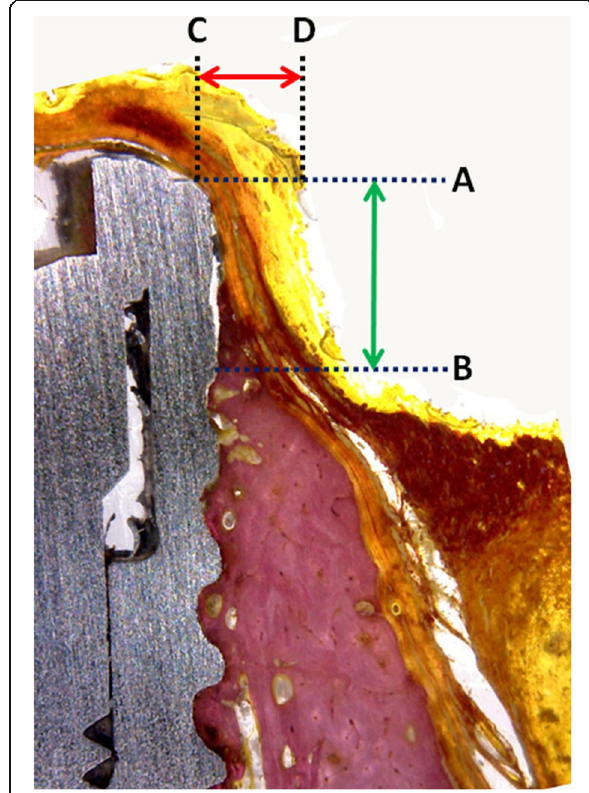
Fig. 2 Parameters measured in each group. Crestal bone loss is the distance between the implant collar (A) and the first bone contact of the crestal bone (B) = A-B bone height; and, the tissue thickness that is the distance from the implant collar (C) to the more external portion of the tissues (D) = C-D tissue thickness. Picrosirius red staining. Original magnification